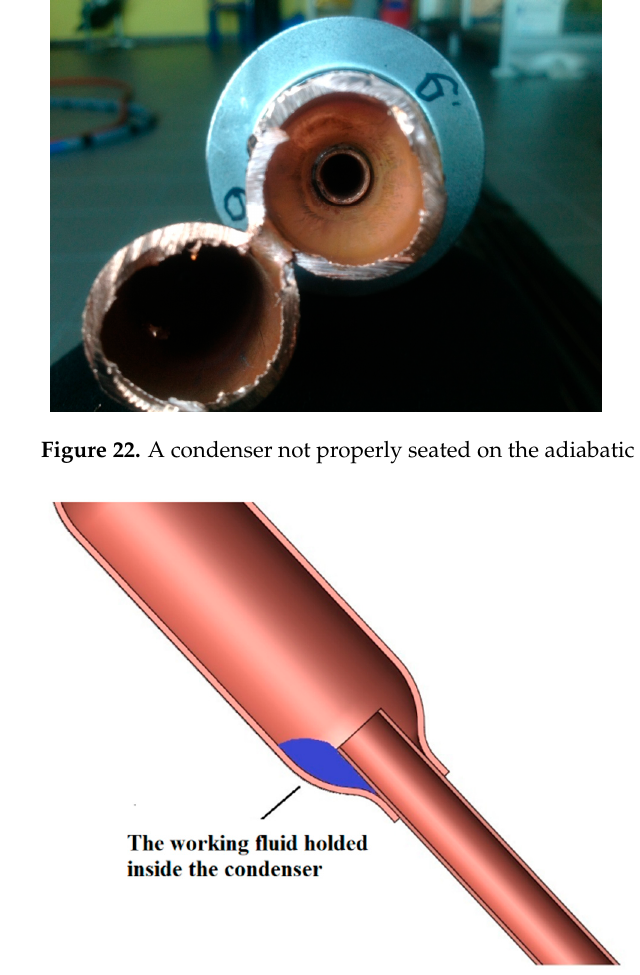
Figure 23. Suspension of the working fluid inside the evaporator.